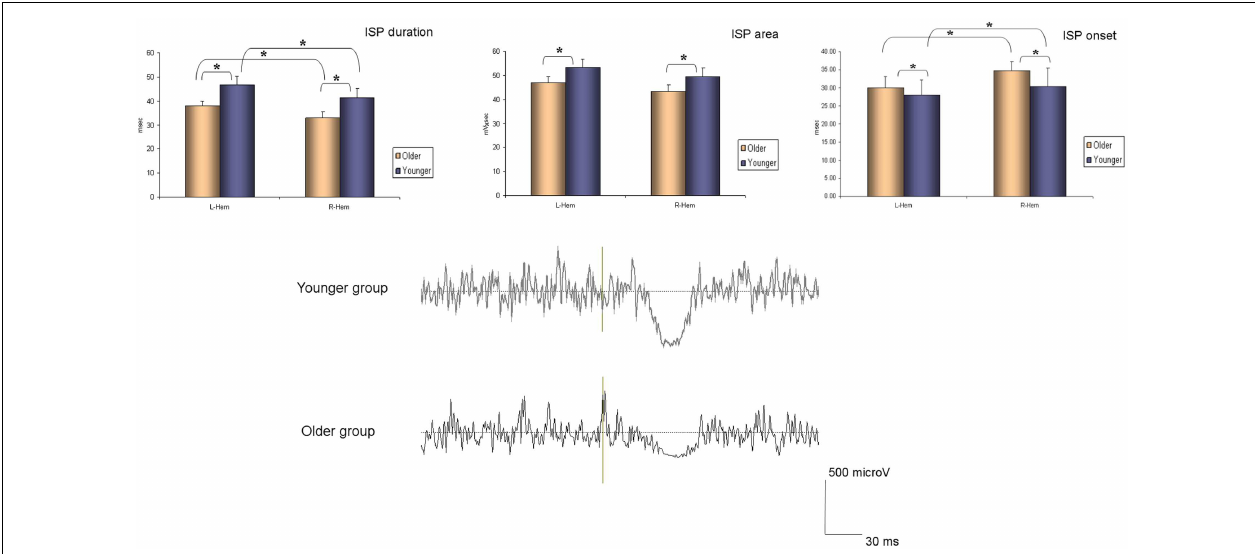
FIGURE 1 | Ipsilateral silent period parameters (duration, area, and onset) according to group and side (average ± SD) . L-Hem, left hemisphere; R-Hem, right hemisphere. * p < 0.05. Examples of ISP traces in one older and one younger subject are exposed on the lower part of the figure.